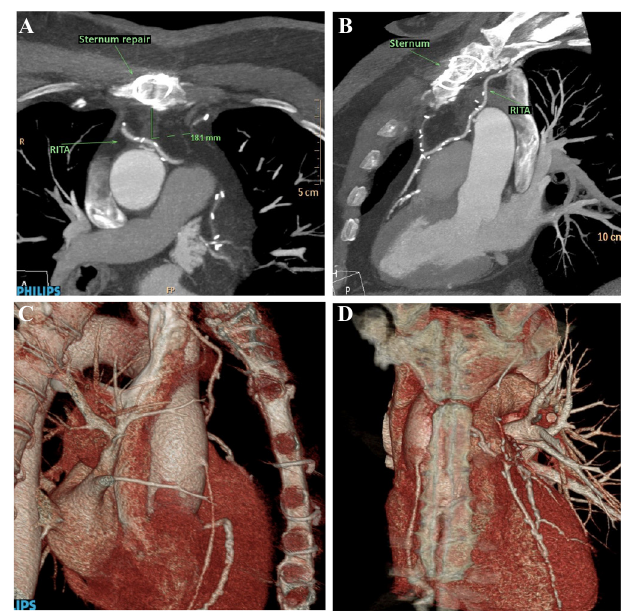
Fig. 4 - (A, B, C and D) - CT angiography showing the positioning of the right internal thoracic artery showing its distance from the